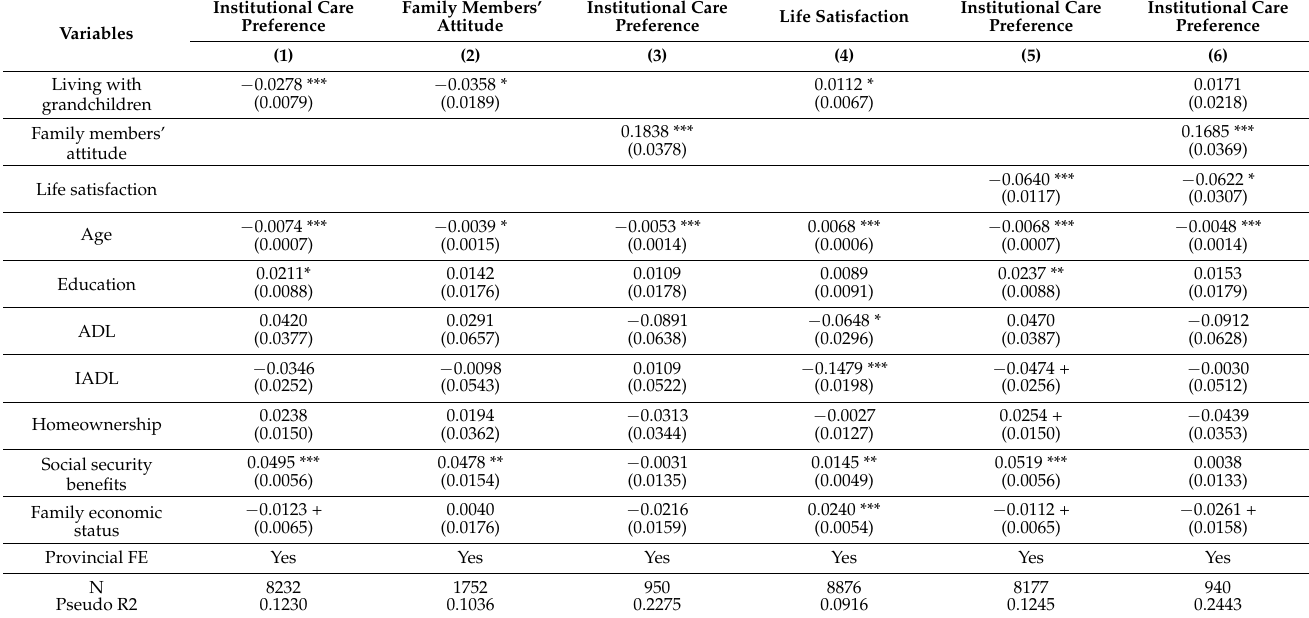
Table 2. Marginal effect on determinants of institutional care